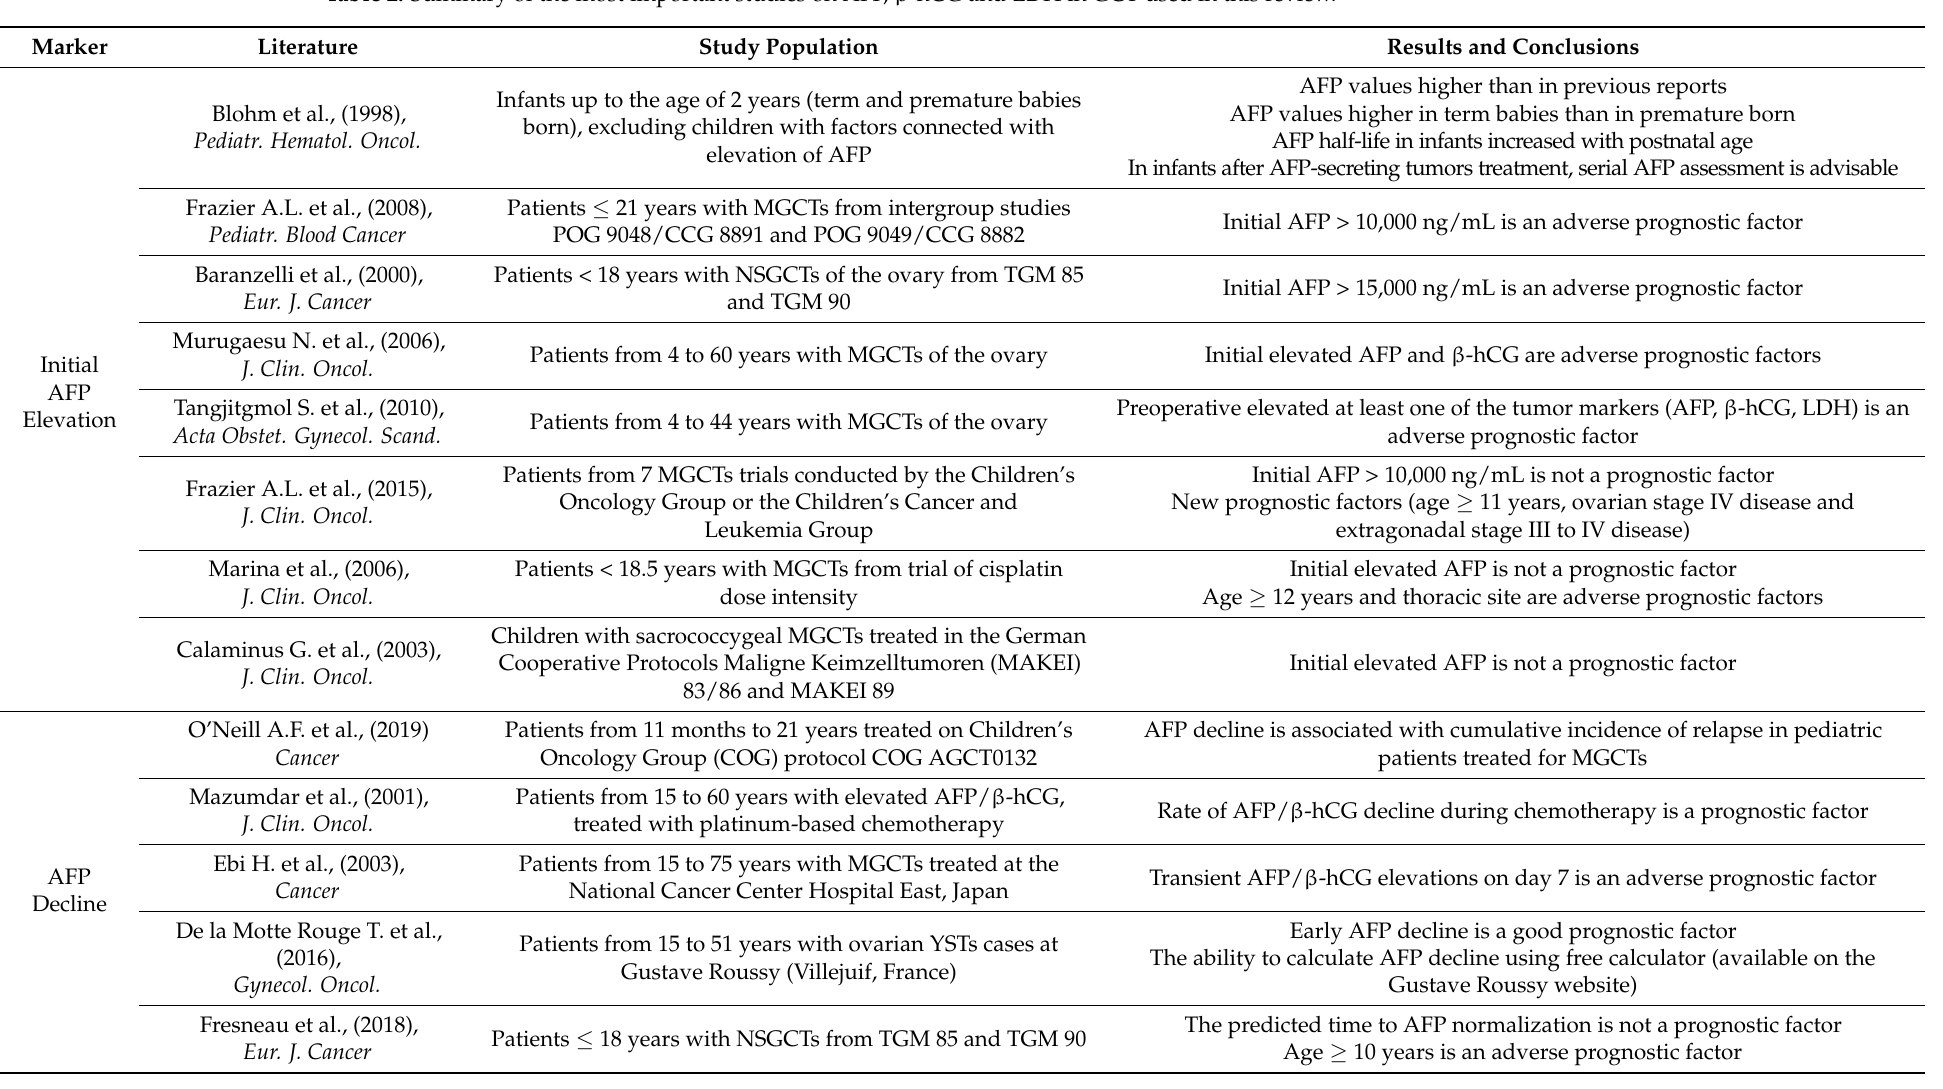
Table 2. Summary of the most important studies on AFP, β -hCG and LDH in GCT used in this